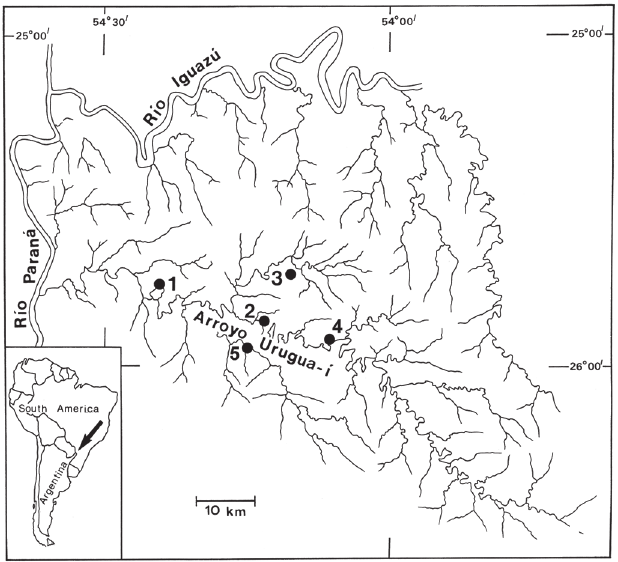
Fig. 6. Distribution of Crenicichla ypo in the Province of Misiones, Argentina. 1- Isla Palacio, 2- Parque provincial Isla Malvinas, 3- Arroyo Grapia and Arroyo Uruzú, 4- Establecimiento “Alto Paraná” (type-locality), and 5- Arroyo Falso Urugua-í.